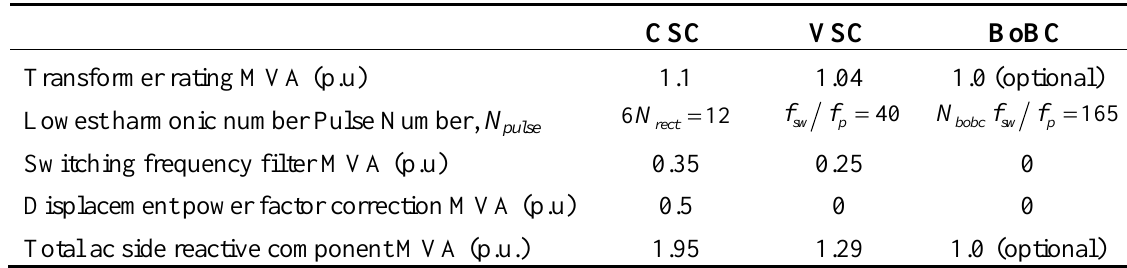
Table 4. AC side reactive component